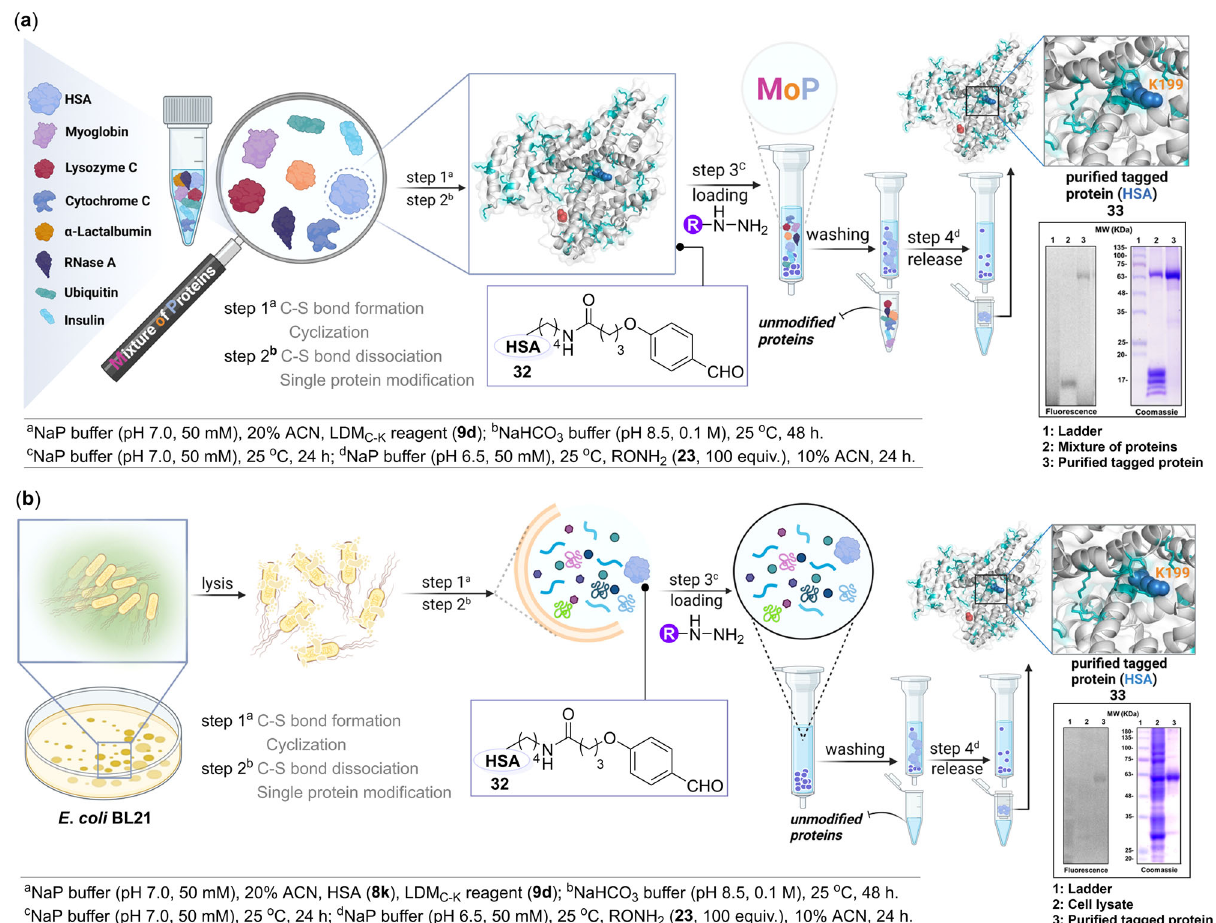
Fig. 7 | Protein-selectivity coupled with chemoselectivity and site-selectivity andthepuri fi cationwork fl ow. Single-site,single-proteinlabelingofhumanserum albumin in a mixture of proteins (MoP), and b cell lysate. Hydrazone formation